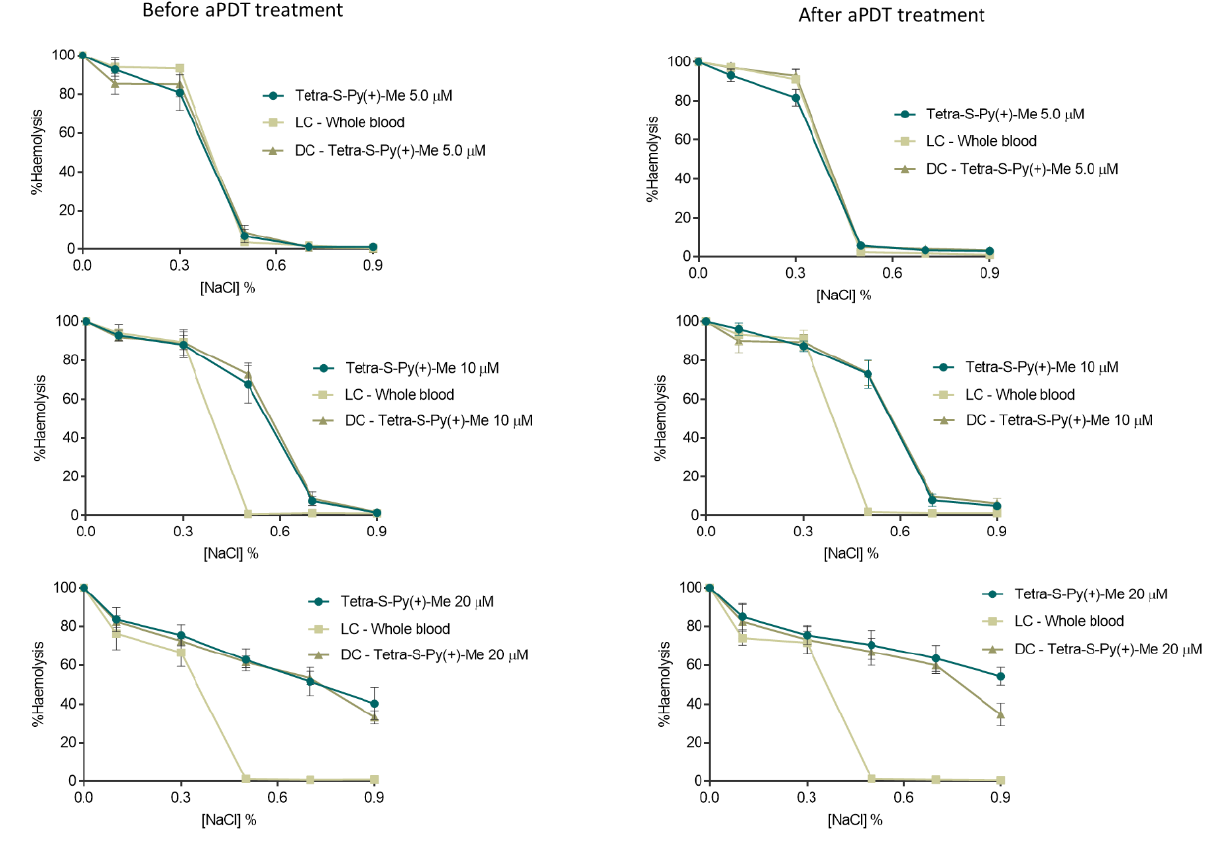
Figure 3. Erythrocyte osmotic fragility before and after aPDT treatment with Tetra-S-Py(+)-Me (5.0, 10 and 20 µM) and under white light irradiation at an irradiance of 150 mW·cm − 2 . All values represent the average of three independent assays. Error bars indicate the standard deviation and in some cases are collapsed with the symbols. LC—Light control (whole blood under light); DC—Dark control (whole blood incubated with PS without light).